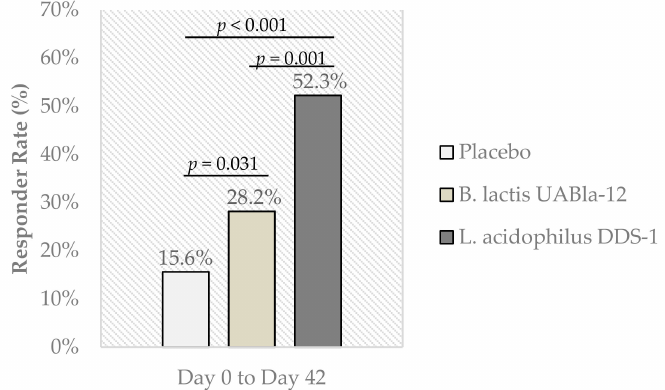
Figure 2. Percentage of significant responders, as defined by a decrease of 30% or more in the Abdominal Pain Severity – Numeric Rating Scale (APS-NRS) (primary outcome) from day 0 to day 42. Responder rate based on all subjects enrolled in ITT population. Between group comparison assessed by Pearson Chi Square